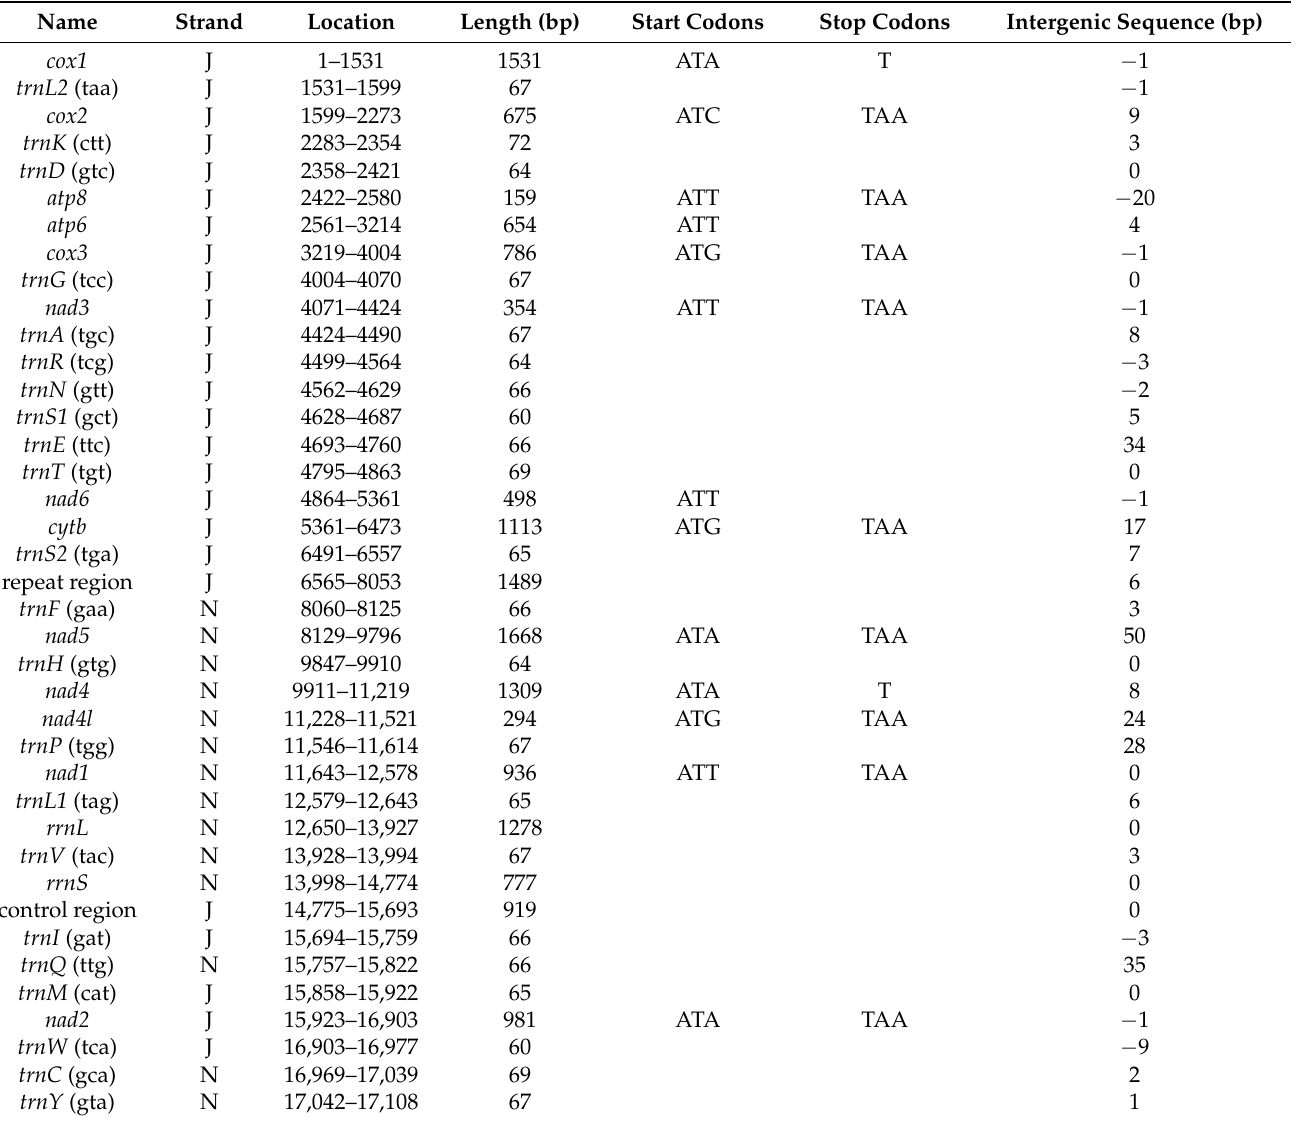
Table 2. Features of the mitochondrial genome of Stomaphis sinisalicis